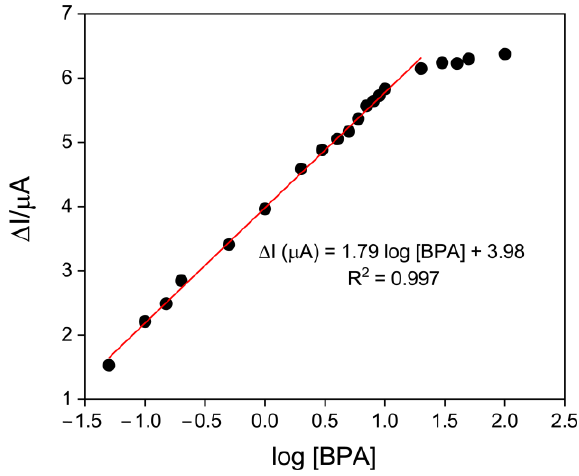
Figure 4. Calibration curve for BPA detection for the PA6/PAH@AuNPs/Tyr/FTO electrode, with the corresponding linear fitting.